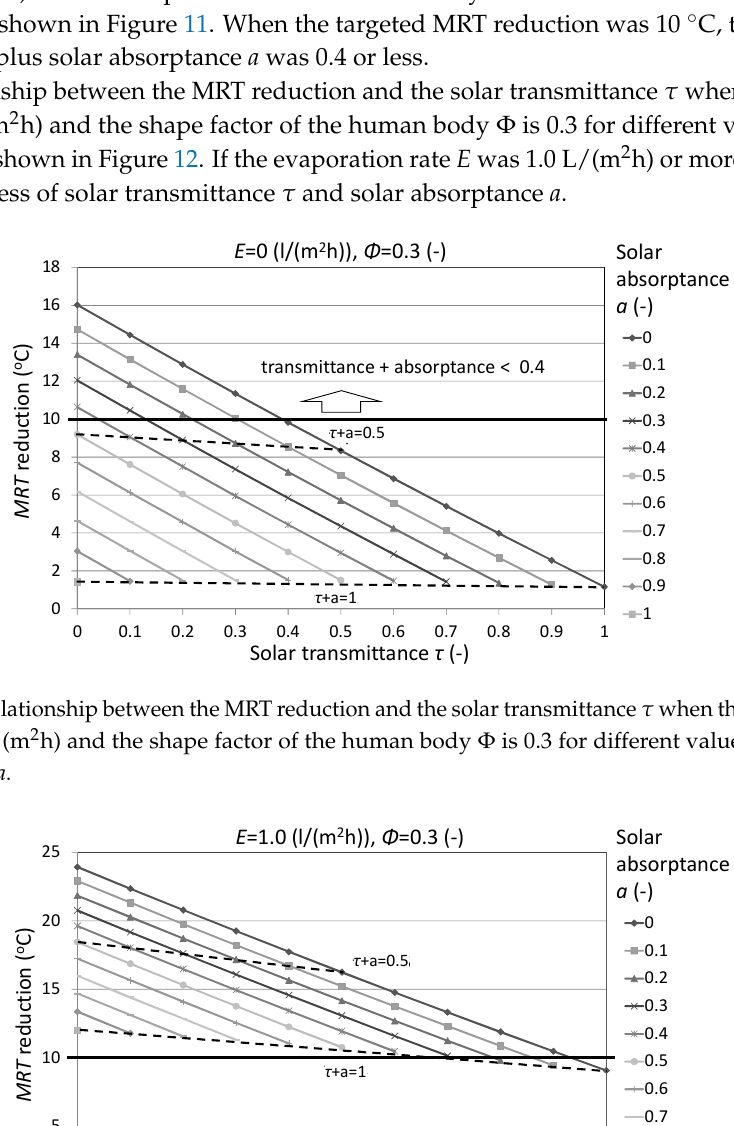
Figure 12. Relationship between the MRT reduction and the solar transmittance τ when the evaporation rate E is 1.0 L/(m 2 h) and the shape factor of the human body Φ is 0.3 for different values of the solar absorptance a .